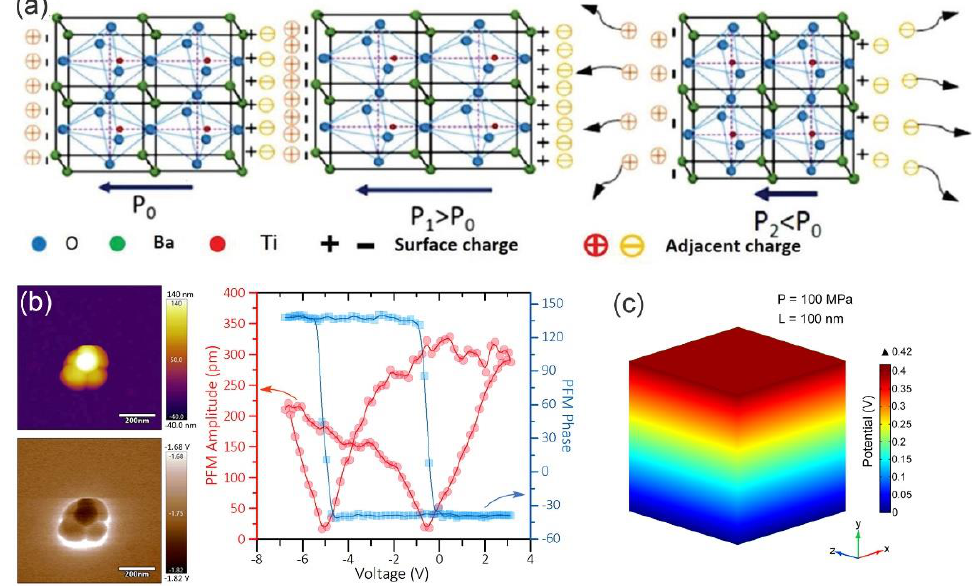
Figure 4. ( a ) Schematic illustration of charge migration within BTO unit cell with variations in stress. Reproduced with permission [36]. Copyright 2015, American Chemical Society. ( b ) Topographic im- age and corresponding phase hysteresis and amplitude butterfly loops of a BTO nanocube measured using PFM. ( c ) Finite element analysis of the electric field of BTO nanocubes at pressure of 100 MPa. Reproduced with permission [37]. Copyright 2022, American Chemical